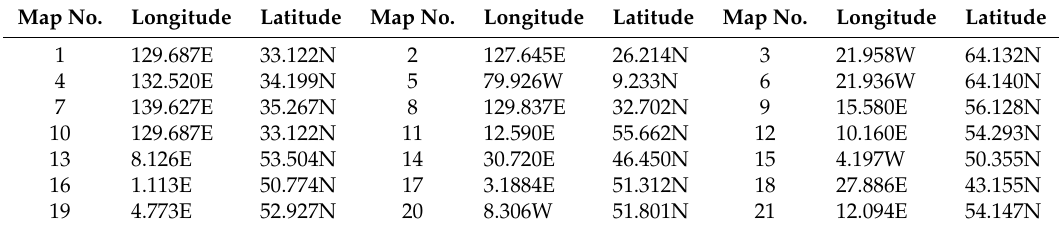
Table 2. Coordinates of maps used in Google Map dataset